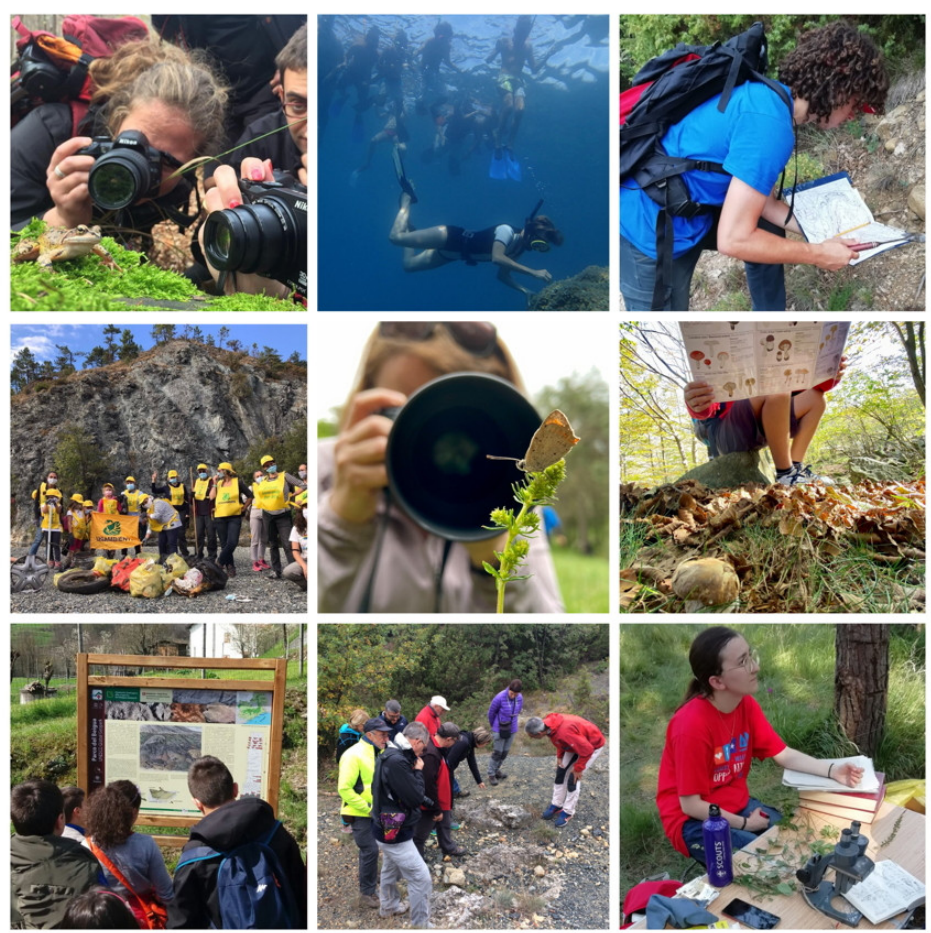
Figure 6. Views of the educational and touristic activities developed at the Beigua UGGp. To these data must be added all hikers and bikers who use the network of trails that include the analyzed geosites. By way of example, two eco-counters along the paths of sites G3 and GD6 reported an average annual inflow of 49,106 passers-by (range over ten years 35,511–77,470). Extending these data to the entire set of sites studied (i.e., to those